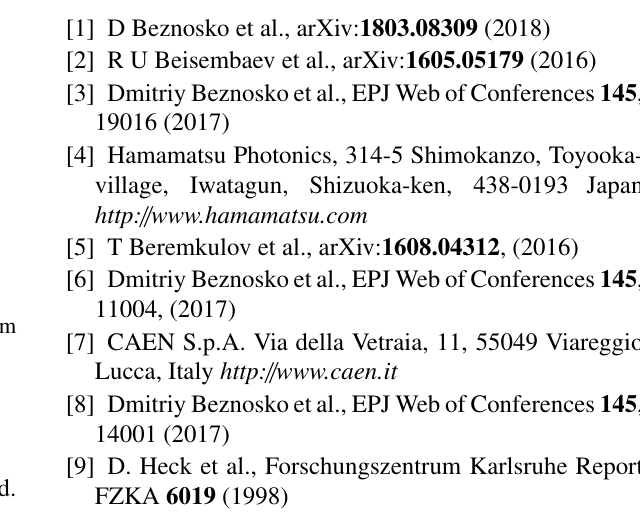
from the axis, so only a single widened pulse is